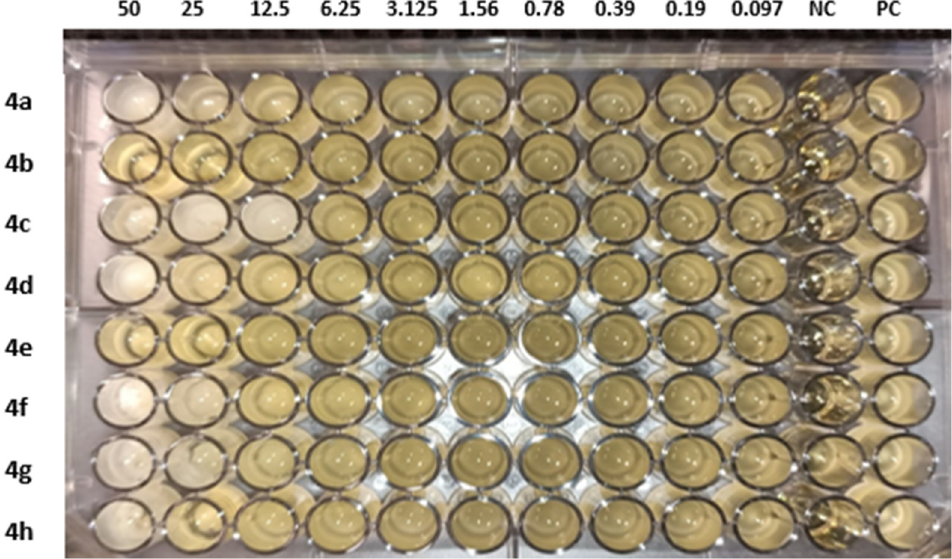
Figure 5. MIC of compounds ( 4a – h ) against ESBL-producing E. coli ST131. NC: negative control and PC: positive control .